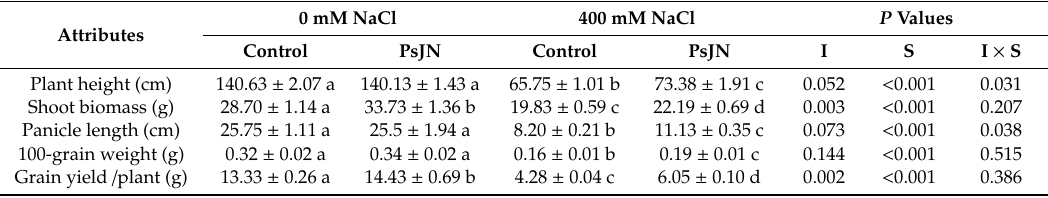
Table1. Growthandyieldparametersofquinoainfluencedby Burkholderiaphytofirmans PsJNinoculation under di ff erent salinity levels (0 mM and 400 mM NaCl).